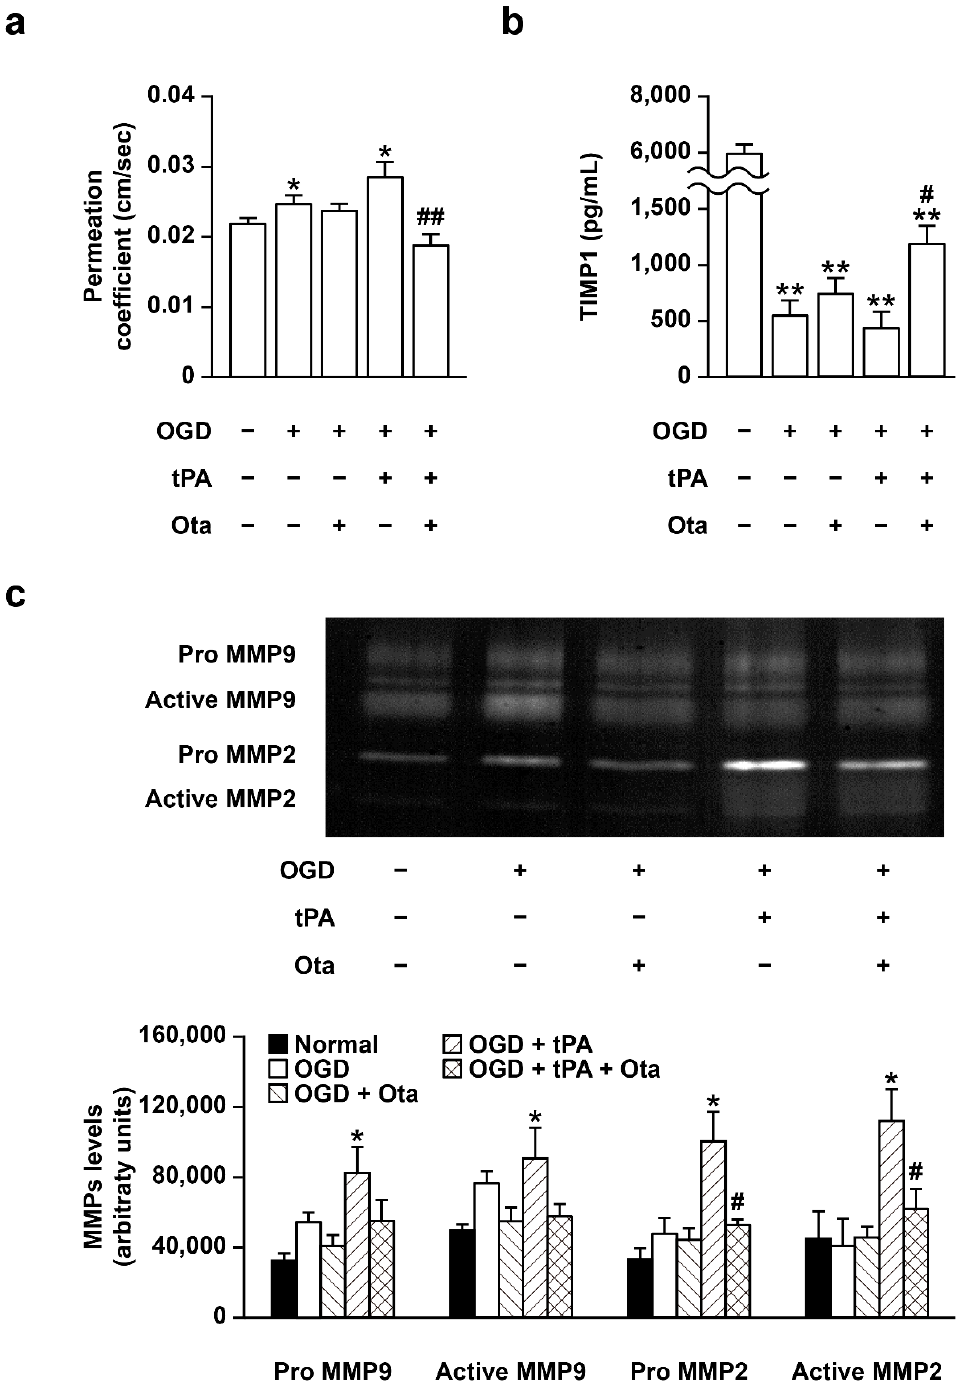
(Figure 5b) and suppressed MMP activities (Figure 5c) induced by OGD/rtPA. However, single cultured endothelial permeability was not affected by OGD/rtPA exposure (Sup- plementary Figure S2). The difference in the permeability of single cultured endothelial cells and the permeability of co-cultured endothelia with mixed glia may be influenced by surrounding cells such as glial cells. This hypothesis is supported by a previous study showing that the interaction between astrocyte and endothelial cells affects the permeability of the endothelial blood–brain barrier [19].